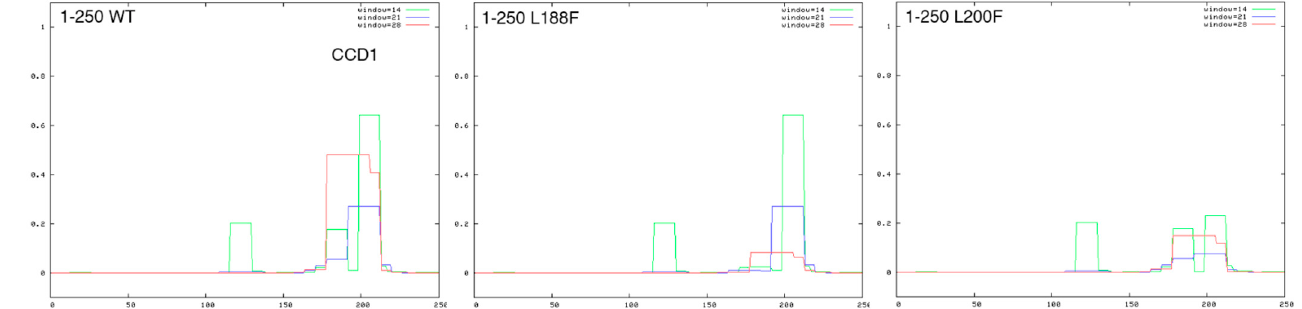
Figure 2. Missense mutations in the SPECC1L CCD1 domain. Coiled coil prediction of the first 250 residues of the SPECC1L WT (left box), Leu188Phe (middle box), and Leu200Phe (right box) sequence was performed with the ExPasy COILS tool (https://embnet.vital-it.ch/software/COILS_form.html, accessed on 3 December 2021). On the X axis is the aa position and, on the Y axis, the coiled-coil score (threshold 0.5). The color of the curves indicates the three window sizes used in the prediction (green, 14 aa; blue, 21 aa; red, 28 aa).